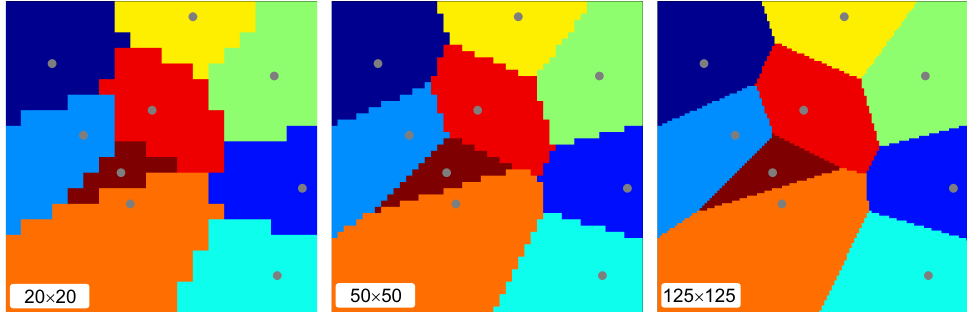
Figure 3. Approximate Voronoi diagrams. Note that accuracy depends on the lattice